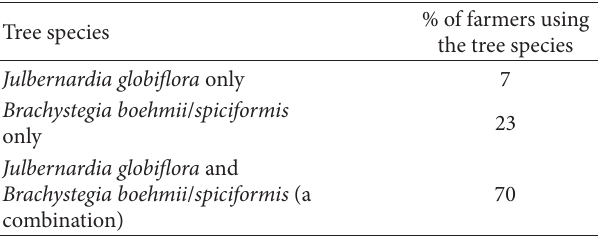
Table 2: Distribution of tree species used for tobacco curing in Hurungwe